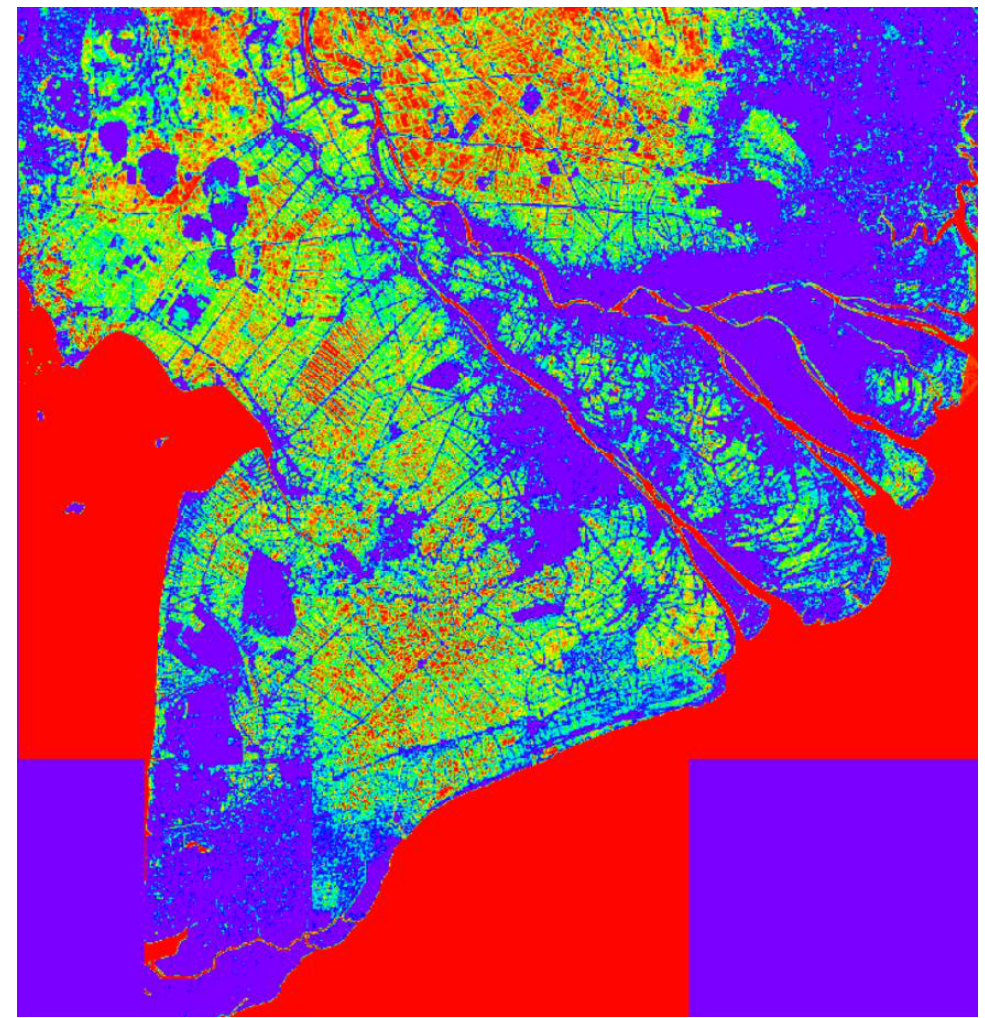
Figure A2. A floodability map (ratio between the cumulative ALOS-2/PALSAR-2 LSWC divided by the cumulative ALOS-2/PALSAR-2 observation times). The visualization was performed using the equalization method, and the spatial resolution was downgraded to 250 m. Red pixels indicate frequently inundated areas, and blue pixels indicate infrequently inundated areas or data not analyzed (right bottom and left bottom square-shaped areas).